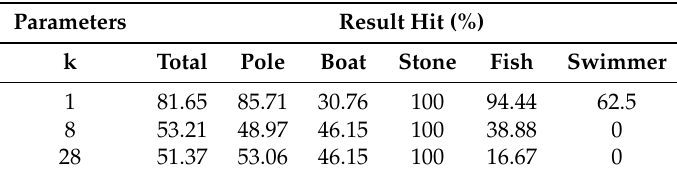
Table 9. Unbalanced 10D Feature results—K-Nearest